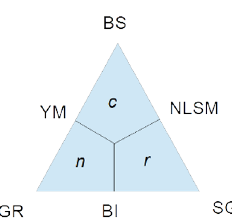
Figure 1 . A web of theories whose amplitudes are the products of colour ( c ) or kinematical ( n, r ) factors subject to Jacobi-like